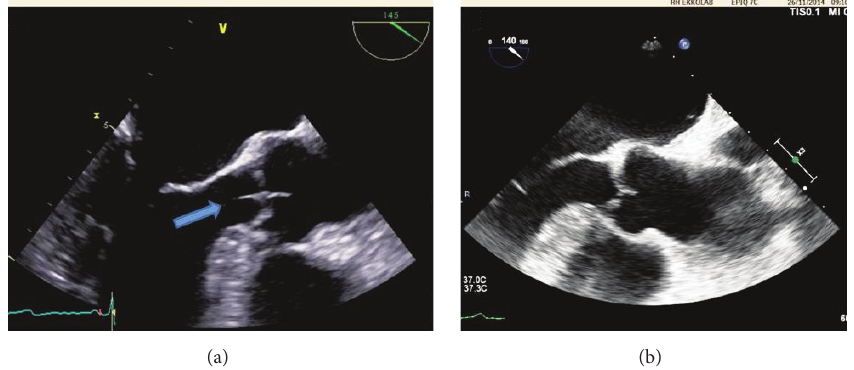
Figure 1: A longitudinal TEE still picture of left ventricle outflow track and the aortic valve. (a) The examination, which led to the surgery, is shown. The arrow marks a thin approximately 10 mm long vegetation with classic location and substance equivalent to Lambl excrescence. (b) A TEE performed after the cancellation and the prior finding is not